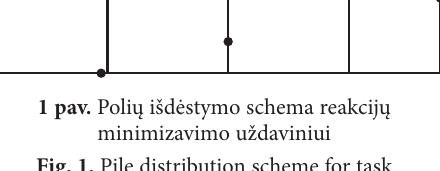
Fig. 1. Pile distribution scheme for task of reactive forces minimization